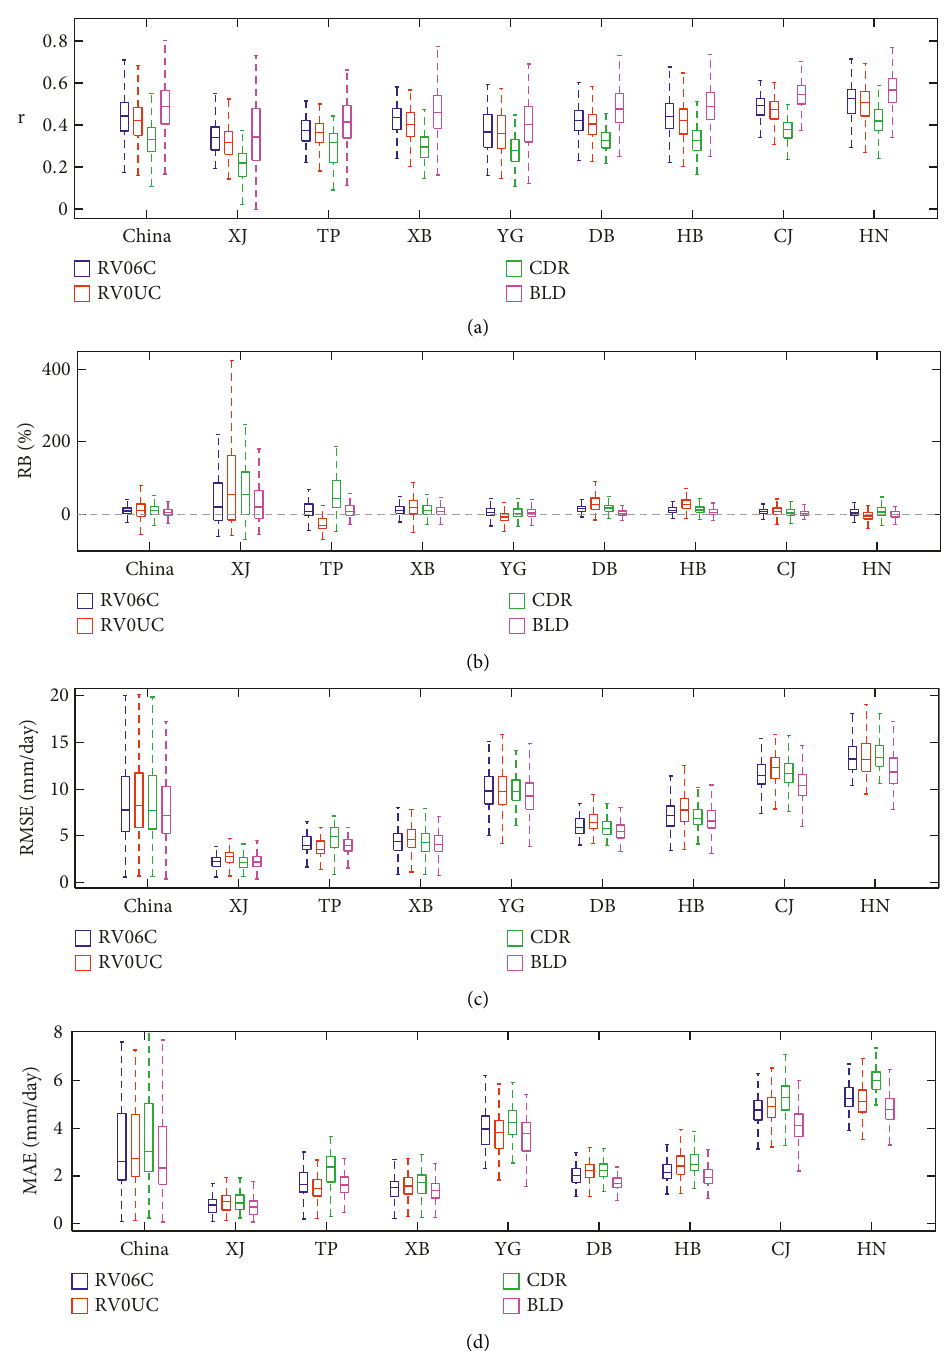
Figure 6: Boxplots of (a) correlation coefficient ( r ), (b) relative bias (RB), (c) RMSE, and (d) MAE for daily precipitation estimates from RV06C, RV06UC, CDR, and BLD during the period from March 2014 to June 2018 over Mainland China and our eight subregions. The five lines from top to bottom for each box describe the maximum value, 75th percentile, 50th percentile, 25th percentile, and minimum value levels,